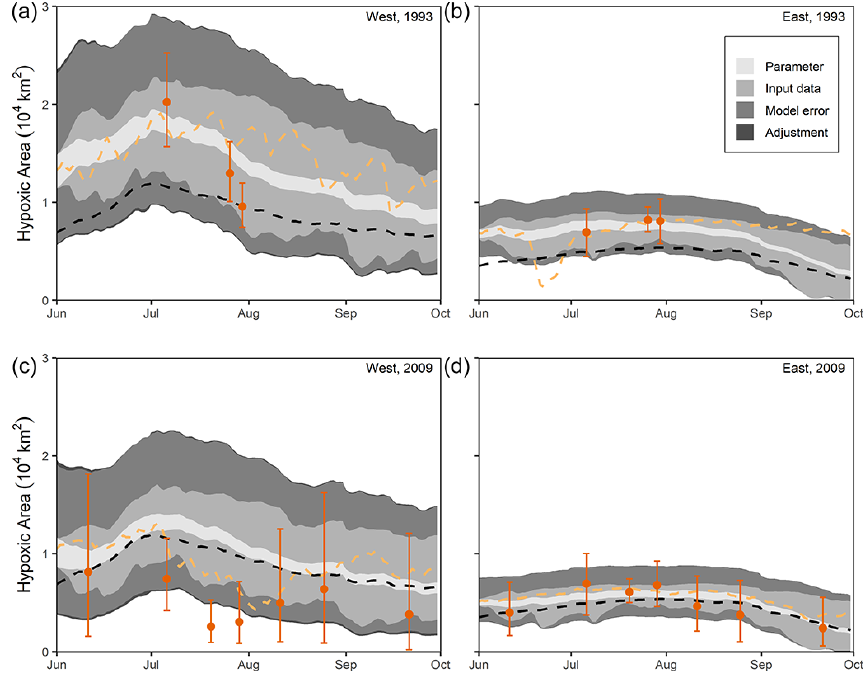
Figure 5. Daily pseudo-forecasts of HA for the western and eastern sections in 1993 (a,b) and 2009 (c,d) , including the 95% IQR of the predictive distribution, distinguishing between (i) parameter, (ii) riverine and meteorological inputs, (iii) mechanistic model residual error, and (iv) regressions related to transformation of BWDO to HA and bias adjustment uncertainties (shades of gray from lightest to darkest). The yellow dashed line is the hindcasted estimate, the black dashed line is the 32 year average hindcast, and the orange points and error bars represent the mean and associated 95% confidence interval of the (geostatistically estimated) hypoxia observations.